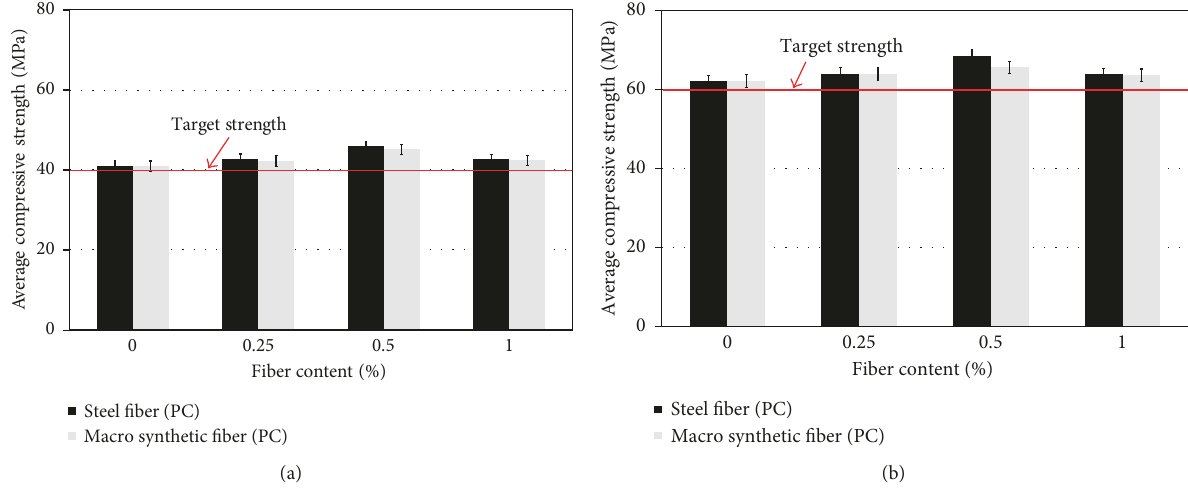
Figure 8: Compressive strength of PC segment with reinforcing fiber type. (a) Target strength 40MPa. (b) Target strength